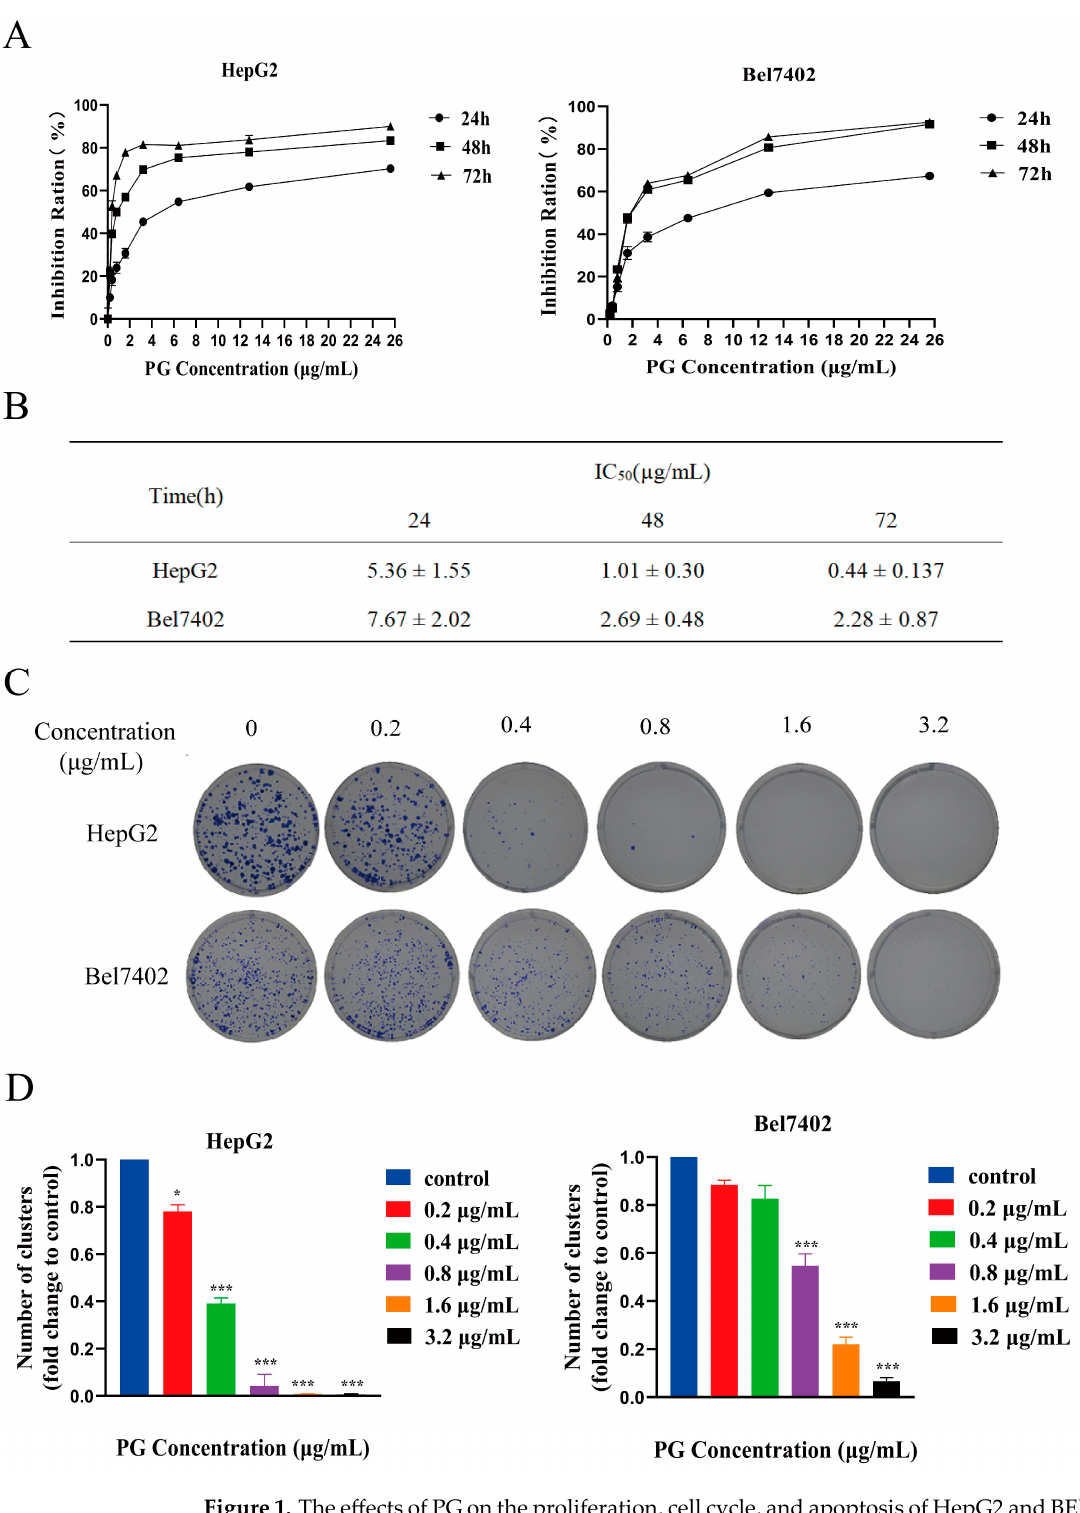
Figure 1. The effects of PG on the proliferation, cell cycle, and apoptosis of HepG2 and BEL7402 cells. ( A ). Inhibition rate of HepG2 and BEL7402 treated by PG for 24 h, 48 h and 72 h, respectively. ( B ). The IC50 values of the cells treated with PG were at 24, 48 and 72 h, respectively. ( C ). The effect of PG on the colony formation property of HepG2 and BEL7402. ( D ) HepG2: PG (1.6 μ g/mL), PG (0.8 μ g/mL) and PG (0.4 μ g/mL) vs. PG (0 μ g/mL), * p < 0.05; *** p < 0.001, n = 3; Bel7402: PG (3.2 µ g/mL), PG (1.6 µ g/mL) and PG (0.8 µ g/mL) vs. PG (0 µ g/mL), *** p < 0.001, n =